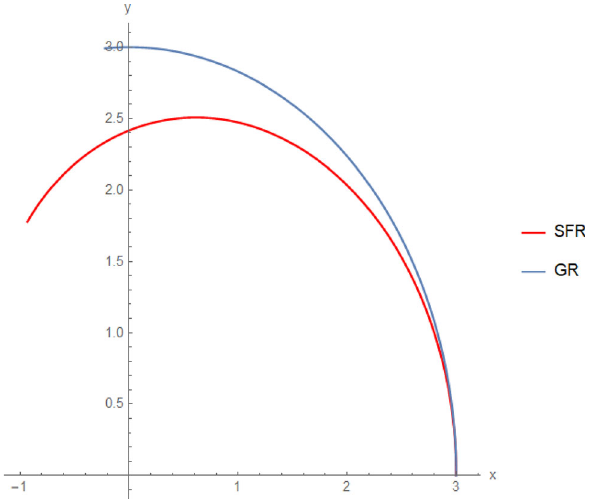
Fig. 2 This is an x–y graph for the geodesics of photons for angular momentum J = 4 and initial radial distance r 0 = 3. The red line shows the SFR geodesics and the blue line the GR